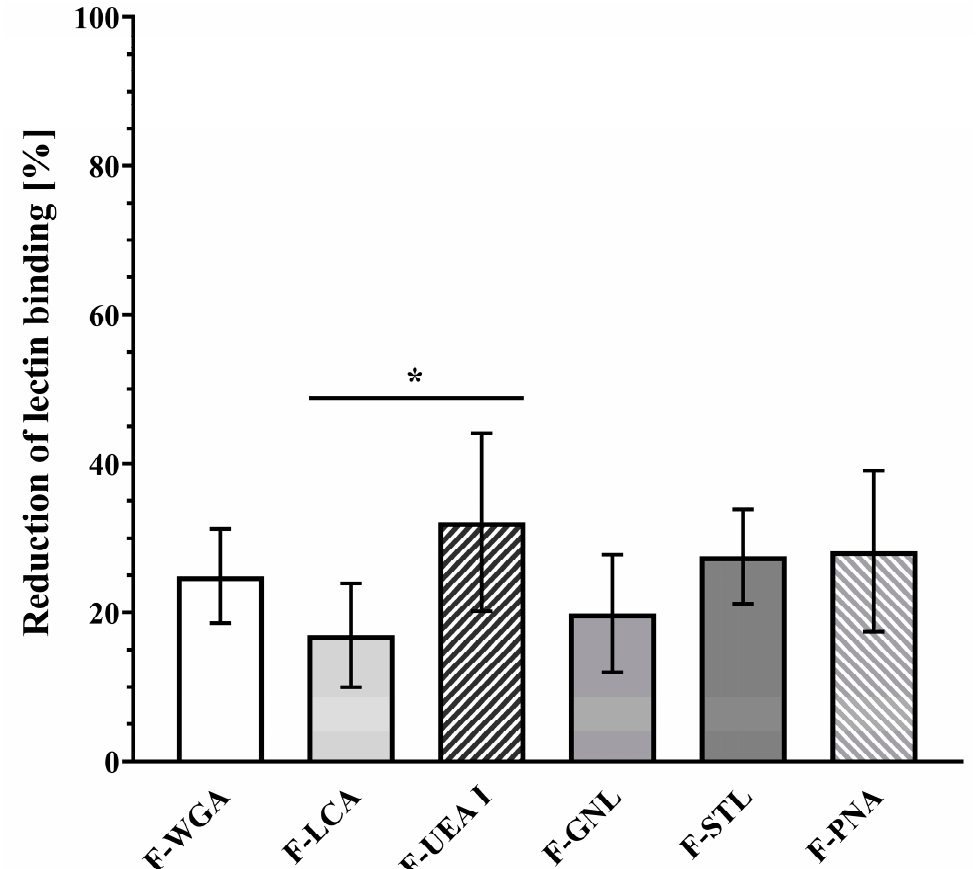
Figure 6. Reduction of mucosa-associated lectin by washing. The values presented were obtained at 37 °C. Statistical analysis did not reveal any significant difference between lectins ( p > 0.05) except for F-LCA vs. F-UEA°I ( p = 0.0463). * p ≤ 0.05.